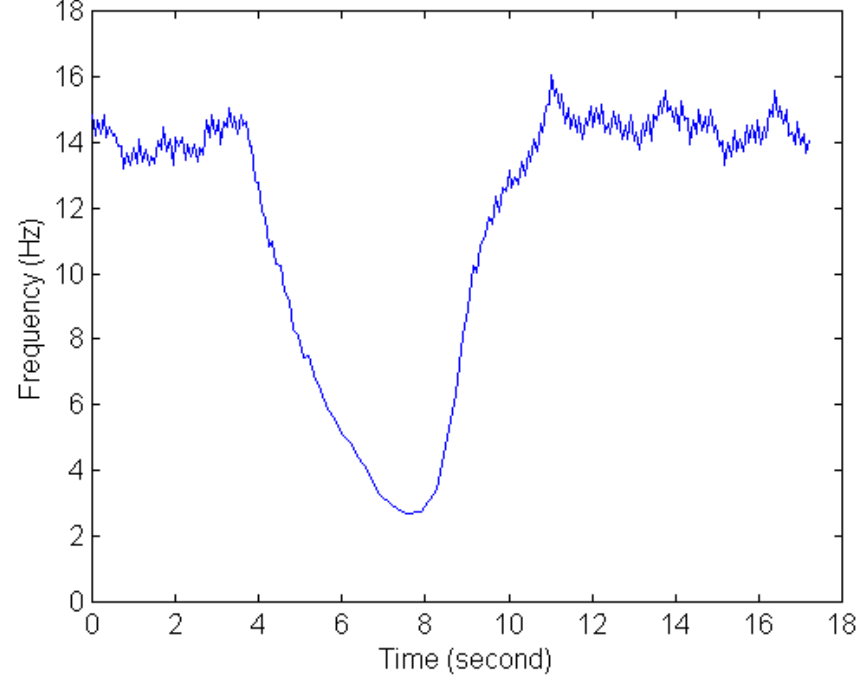
Fig. 1. Curves of the ascending and descending phases of the cup anemometer speed. The wind speed was fixed to 2.84ms − 1 (Anemometer 25-2).